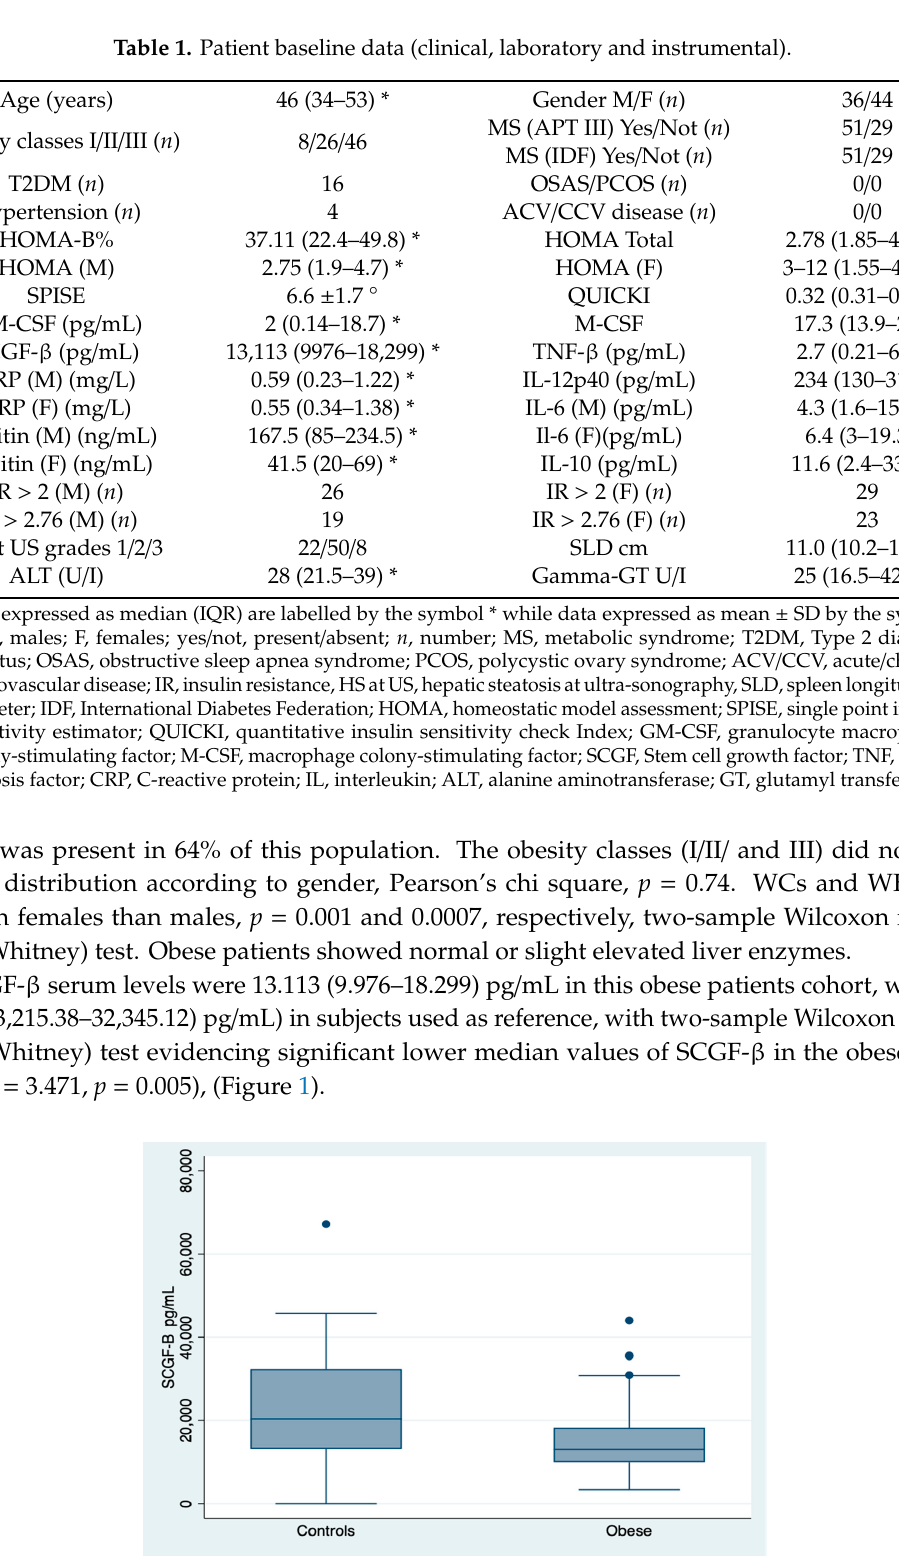
Figure 1. Distribution of stem cell growth factor-beta (SCGF- β ) serum levels in the reference and the obese patients group. It is evident a reduction of SCGF- β levels in the obese patients group compared to reference values (controls) with a modest overlapping. A linear regression analysis was